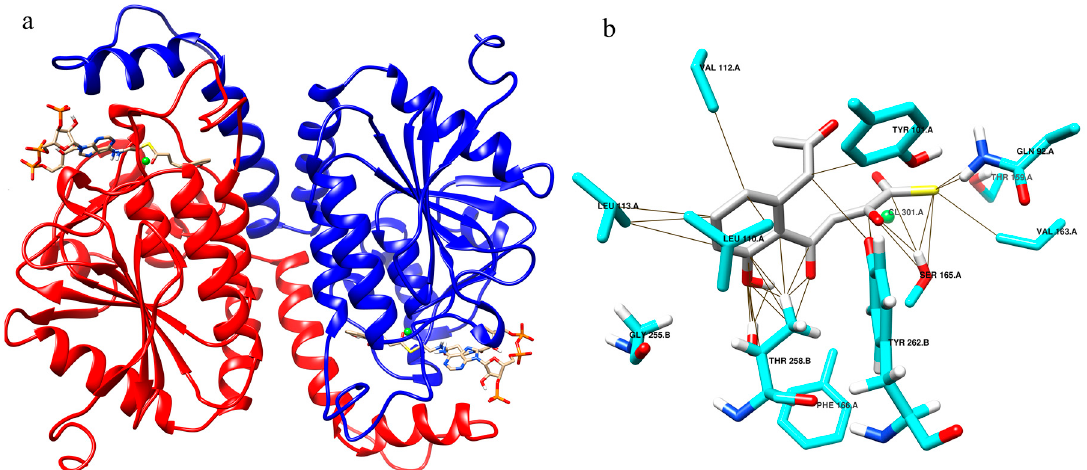
Figure 1. Structure of naphthoate synthase with OMB CoA in the active site. ( a ) Dimer of naphthoate synthase with substrate OMB CoA. ( b ) Neighbors and residues making contacts with OMB in naphthoate synthase.